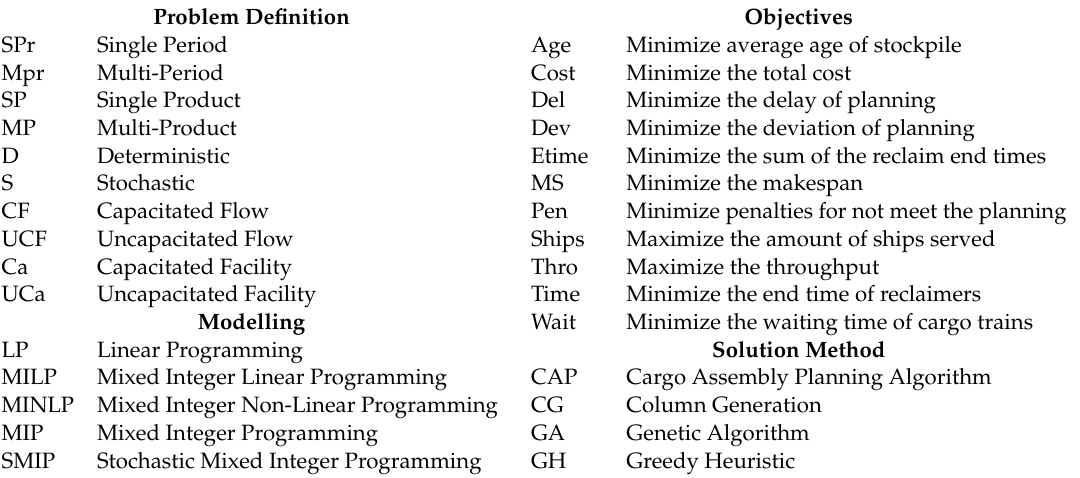
Table 1. Nomenclature used for classification of stockyards planning problems in the literature.